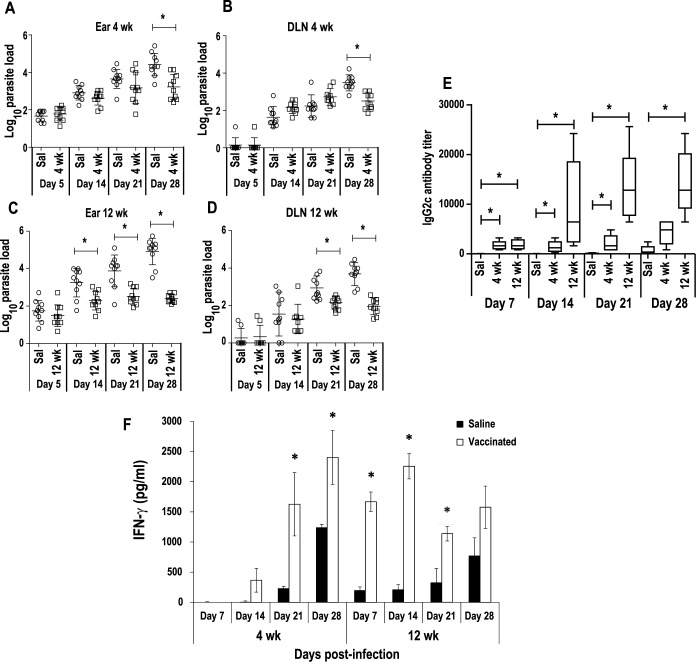
Vaccinated mice mounted an early immune response against Leishmania.Animals inoculated with PBS (Saline) or with 1 × 107
LiΔHSP70-II promastigotes in the right footpad (s.c.) were challenged with 1 × 103 metacyclic L. major promastigotes in the dermis of both ears at week 4 and at week 12 after vaccination. Mice (n = 5) per group were weekly sacrificed to analyze parasite loads in both ears (A and C), or in the corresponding retromandibular draining lymph nodes (B and D). Scatter plots with the individual number of parasites per total organ are shown including the mean ± standard deviation (SD). * (P < 0 .05) shows the statistical differences determined by the unpaired Student t-test. The IgG2c reciprocal end-point titer against L. major SLA was analyzed by ELISA weekly after L. major challenge and represented as whisker (min to max) plots (E). * (P < 0.05) indicates the statistical differences in IgG2c anti-SLA titers among the three groups (Kruskal-Wallis test and Dunn's Multiple Comparison post-test). Level of L. major dependent IFN-γ produced in retromandibular cell cultures (F). Mean ± SD are shown. * (P < 0.01) shows the statistical differences between saline vaccinated mice groups (unpaired Student t-test).